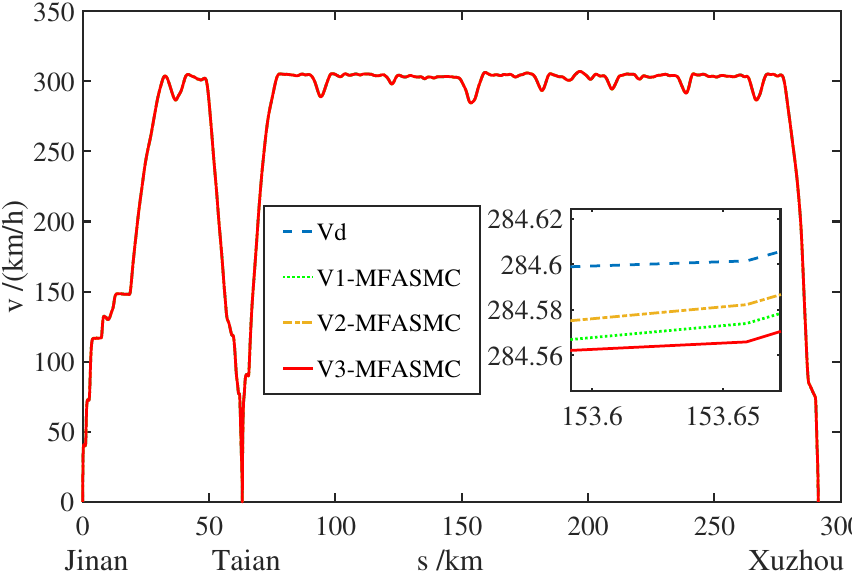
Figure 5. The speed tracking distribution of each power unit of